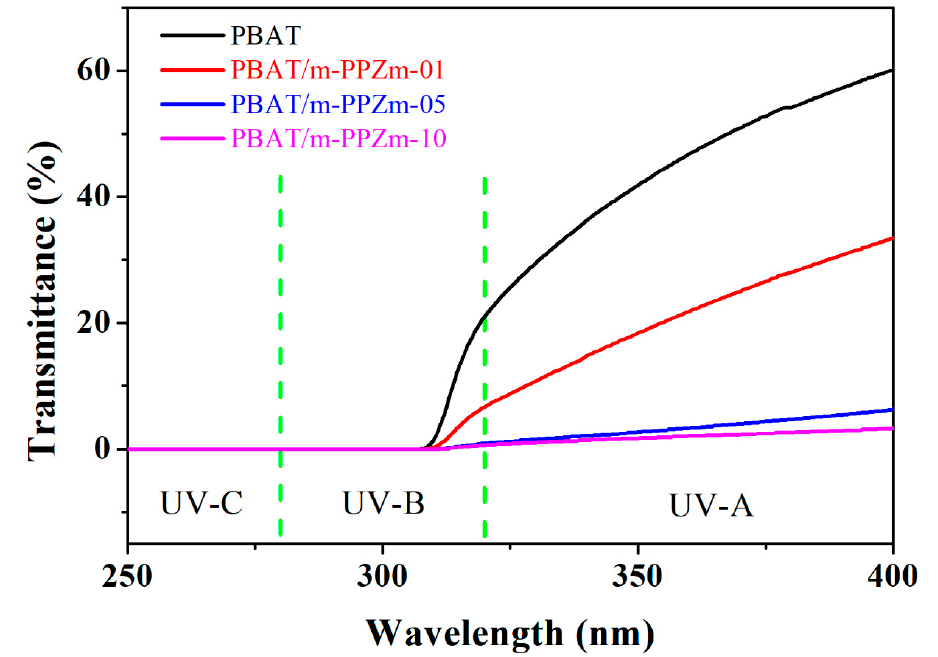
Figure 5. UV–vis result of PBAT and PBAT/m-PPZn composites. Figure 5. UV-vis result of PBAT and PBAT / m-PPZn